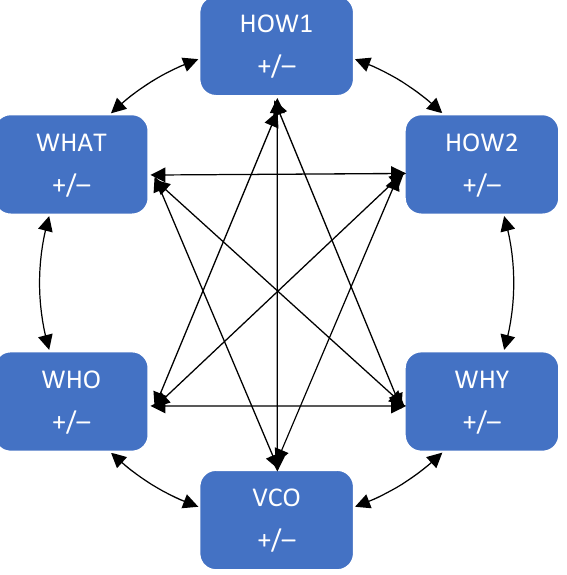
Figure 1. Business model, its elements, and relations. Own interpretation according to [22,40].